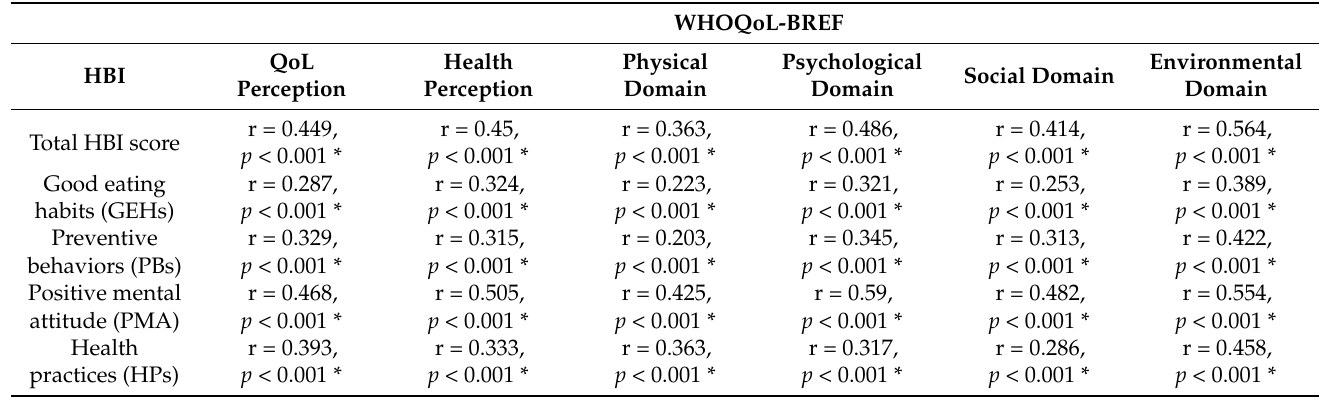
Table 6. The relationship between the HBI components and the WHOQoL-BREF